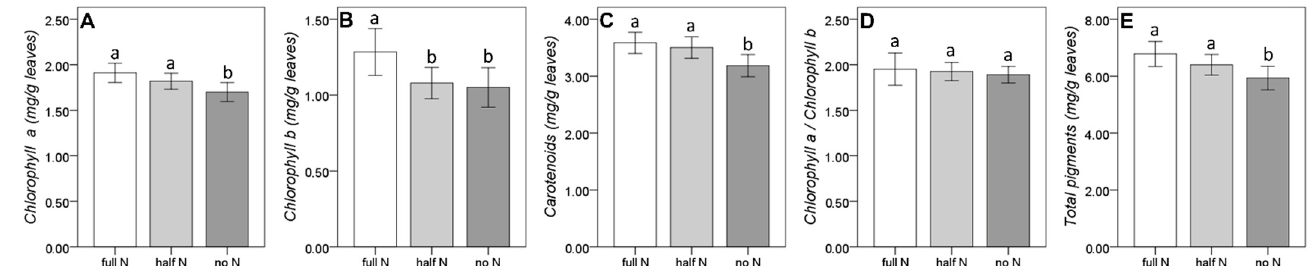
Figure 4. Effect of the short-term nitrogen deficiency on the leaf pigmentation (( A ): chlorophyll a; ( B ): chlorophyll b; ( C ): carotenoids; ( D ): chlorophyll a/chlorophyll b; ( E ): total pigments). Bars represent the standard error; different letters indicate significant differences among group results found by the Duncan post-hoc test.